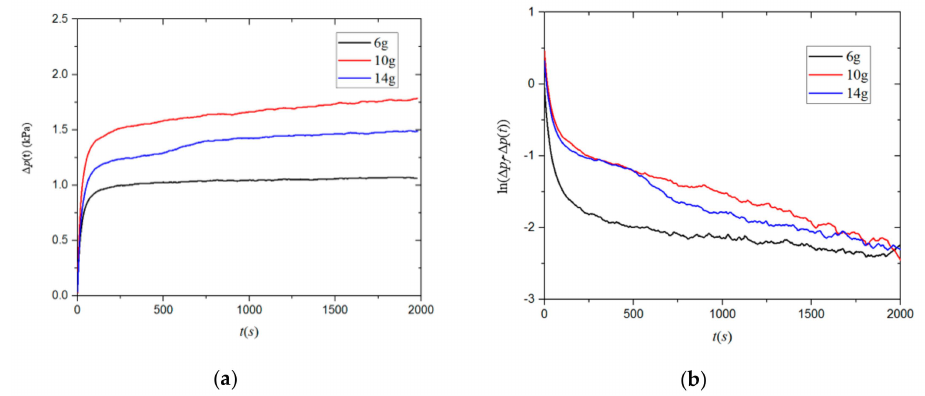
Figure 6. ( a ) The pressure di ff erence signal ∆ p( t ) and ( b ) logarithmic pressure decay curve for sample 1 measured at a pressure of 3 MPa and a temperature of 30 ◦ C The black, red, and blue lines indicate sample masses of 6, 10, and 14 g, respectively.